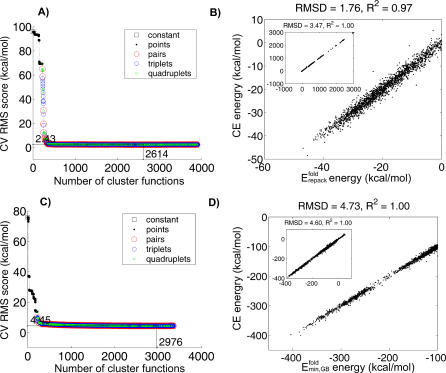
Cluster Expansion of WW-Domain Energies(A) and (B) refer to the CE of

; in (C) and (D),

was used.
(A) and (C) represent the evolution of the CV score (the progress of the fit) as the number of CFs was increased, with the type of CF added at each point (i.e., constant, point, pair, triplet, or quadruplet) indicated by color. The ordering of the points is described in Materials and Methods. The set of CFs and ECI used in the final expansion was taken from the point with the minimal CV score, which is indicated on the graphs.(B) and (D) show the performance of the respective CEs on predicting energies of 4,000 random sequences not included in the training sets. Insets show the entire range of energies, whereas only sequences with reasonably low energies are shown in the main plots.